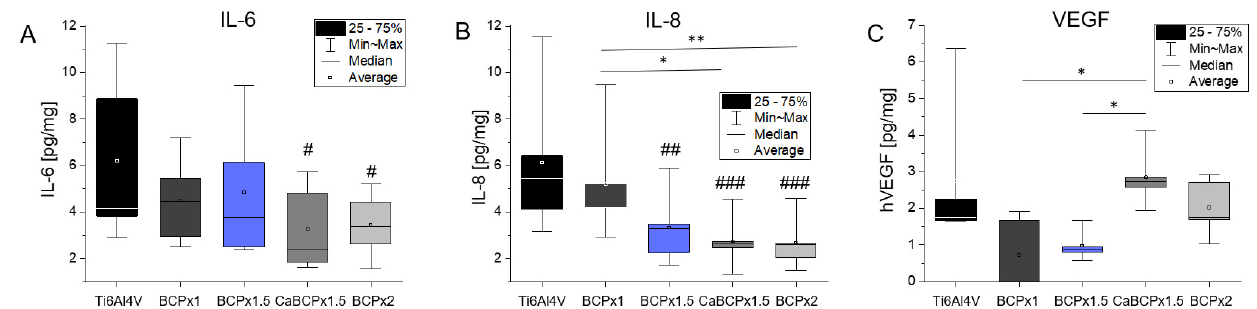
Figure 5. Analysis of biocompatibility from coatings precipitated on chemically pre-treated Ti6Al4V substrates after exposure to BCPx1, BCPx1.5 with and without CaCl2 pre-treatment, and BCPx2 for 14 days using human osteoblasts ( n = 5). ( A ) Interleukine 6 (IL-6) concentration in the cell supernatant normalized to the total protein content of the supernatant in pg/mg. ( B ) Interleukine 8 (IL-8) in the cell supernatant concentration normalized to the total protein content of the supernatant in pg/mg. ( C ) Vascular Endothelial Growth Factor (VEGF) in the cell supernatant concentration normalized to the total protein content of the supernatant in pg/mg. # indicates significant differences between the CaP coatings and Ti6Al4V: # p < 0.05, ## p < 0.01, and ### p < 0.001; * indicates significant differences between CaP coatings: * p < 0.05 and ** p < 0.01.